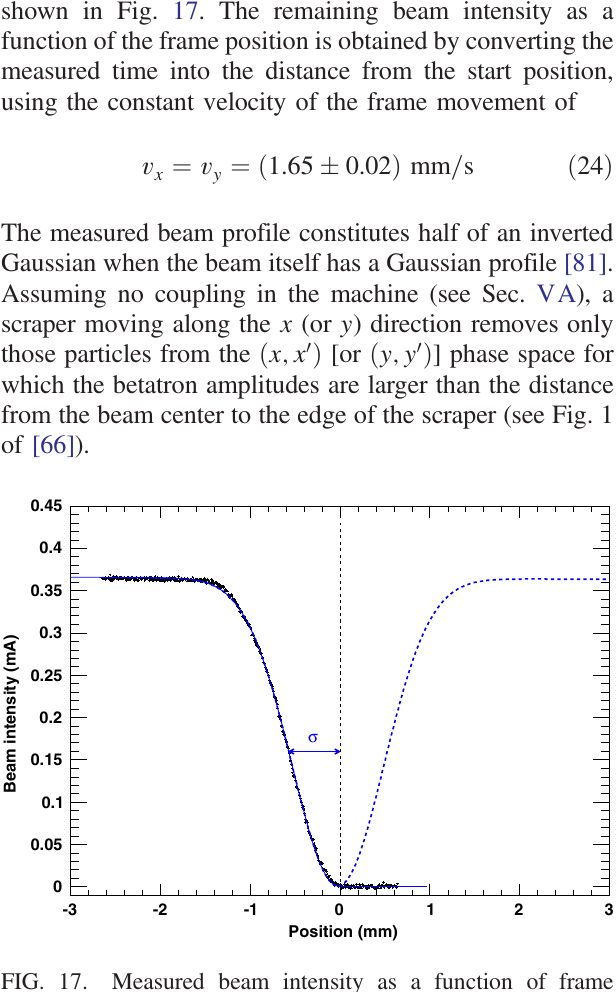
FIG. 17. Measured beam intensity as a function of frame position obtained by moving the frame through the beam. The resulting beam profile (black points) constitutes half of an inverted Gaussian from which σ as a measure of the beamwidth is obtained by fitting using (27) (dashed blue line). The beam intensity with the frame in the nominal position of I 0 ¼ 0 . 35 mA corresponds to about 4 . 67 × 10 9 protons at injection